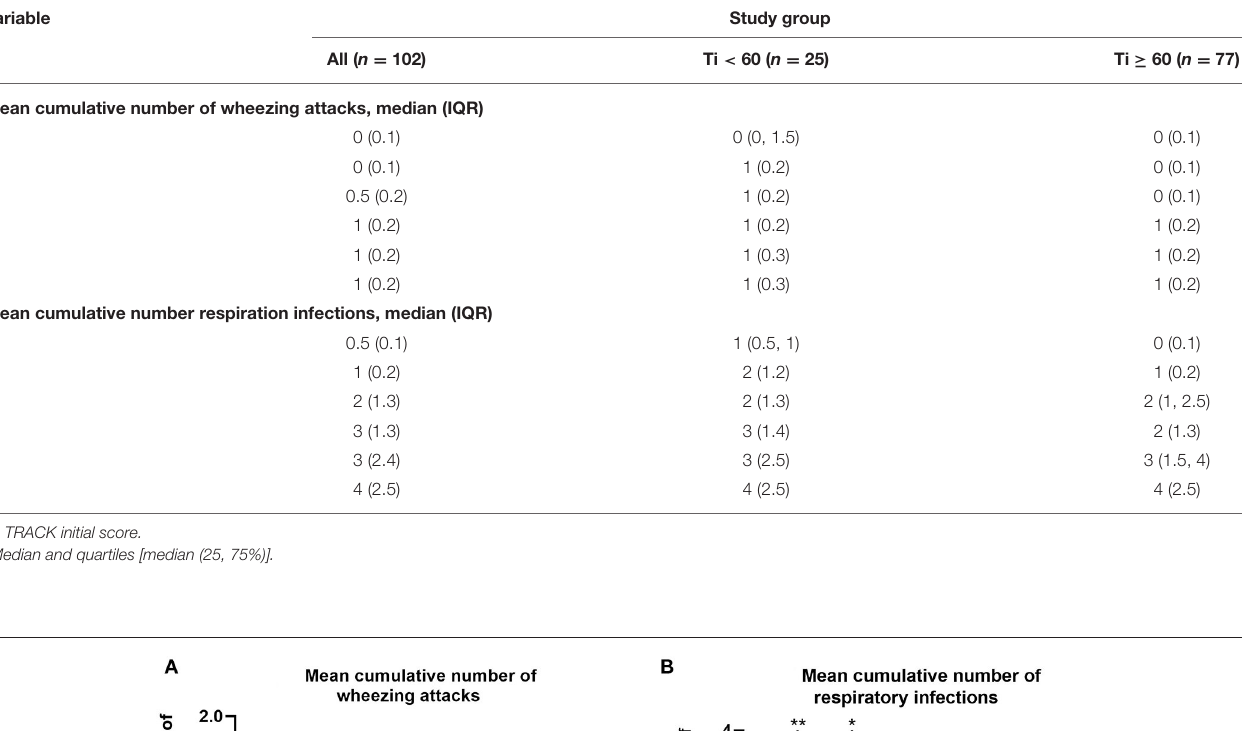
TABLE 4 | Description statistics of outcome variables.